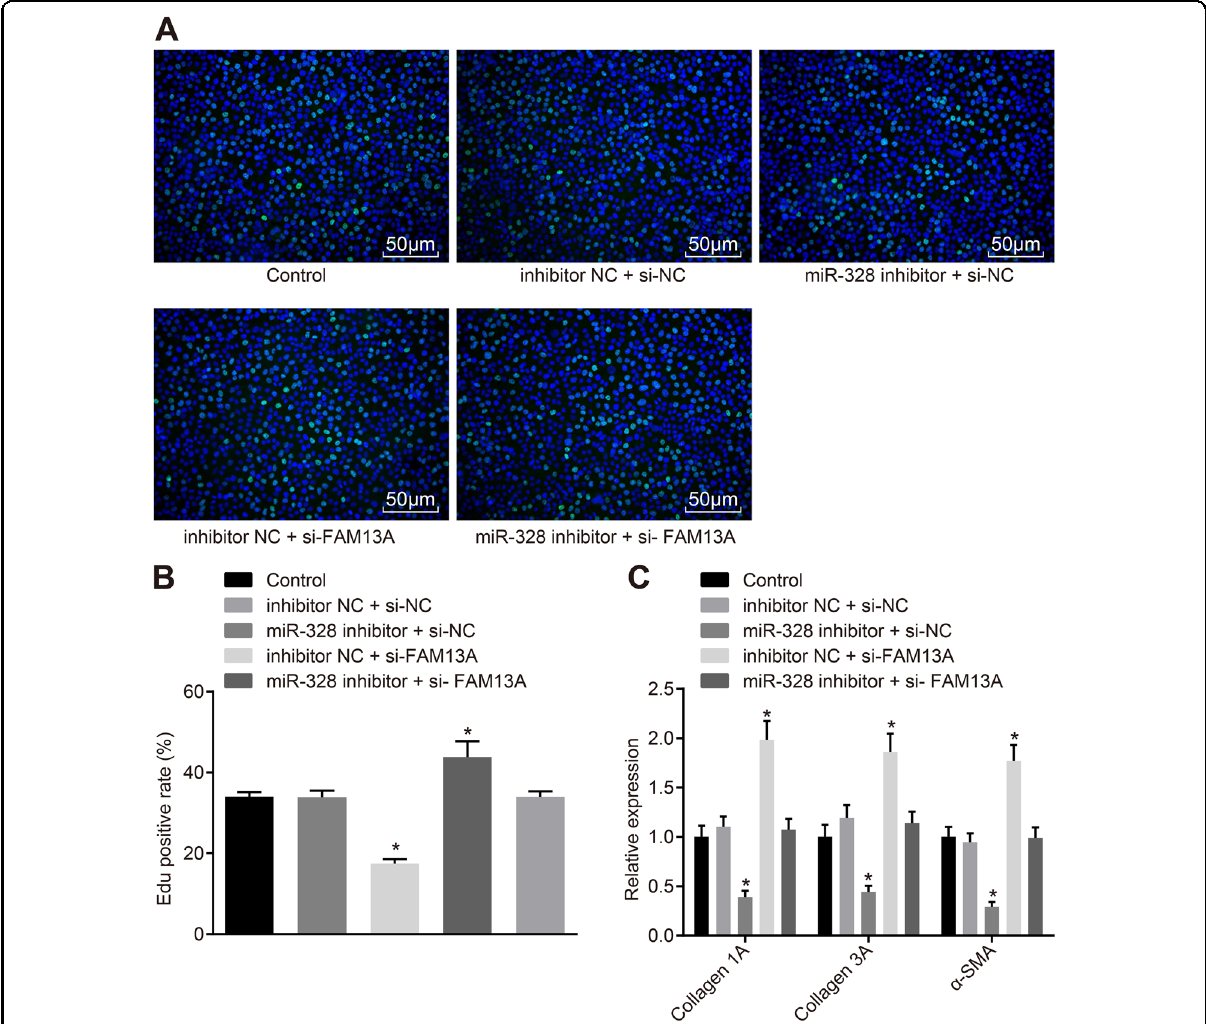
b Quanti fi cation of the results in A; C, RT-qPCR to examine the expression of Collagen 1A, Collagen 3A and α -SMA after the inhibition of miR-328 or silencing of FAM13. miR-328, microRNA-328; FAM13A, family with sequence similarity 13, member A; EdU, 5-ethynyl-2 ’ -deoxyuridine; α -SMA, α -smooth muscle actin; RT-qPCR , reverse transcription quantitative polymerase chain reaction; and NC, negative control. * p < 0.05 vs . the inhibitor NC + si-NC group. The results were measurement data and were analyzed using one-way analysis of variance. The results are expressed as the mean ± standard deviation. The experiment was conducted in